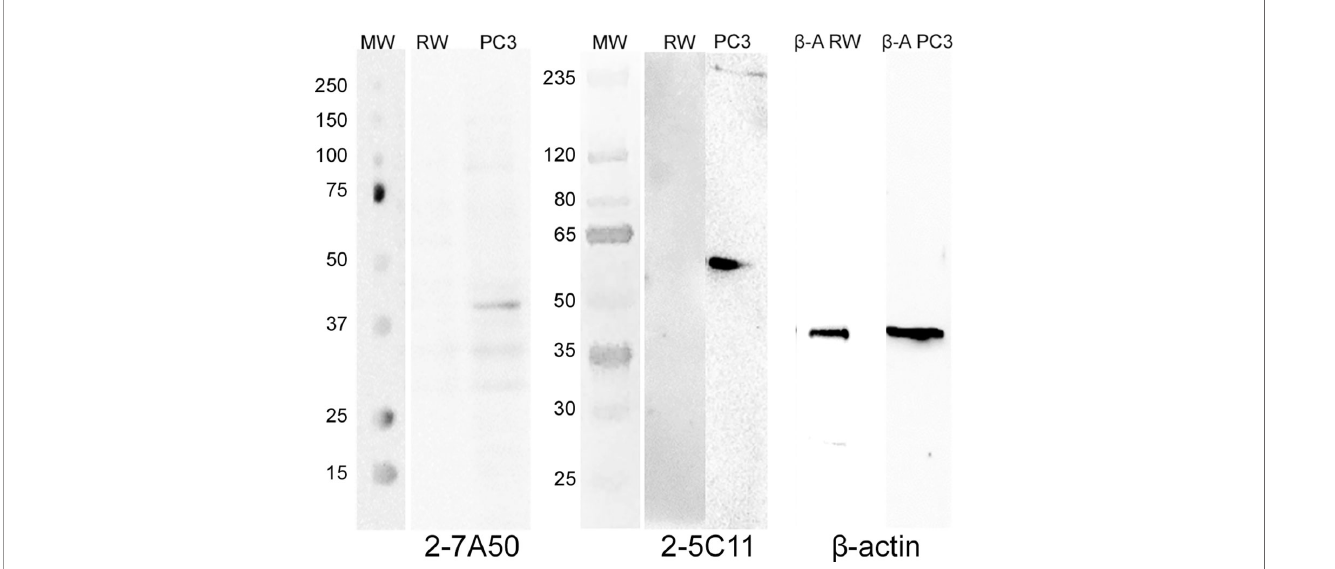
FIGURE 3 | Western blotting of mAbs 2-7A50 and 2-5C11 against cell extracts from tumoral and non-tumoral cell lines. MW: molecular weight marker; RW: RWPE-1 cell line extract; PC-3: PC-3 cell line extract; b -A RW: b -actin antibody against RWPE-1 cell line extract; b -A PC-3: b -actin antibody against PC-3 cell line extract. Both mAbs recognized bands present only at the PC-3 cell line. No reactivity is shown against the RWPE-1 cell line. mAb 2-7A50 speci fi cally detected a 45kDa band while mAb 2-5C11 speci fi cally detected a 62 kDa band. Detection was performed using chemiluminescent method.